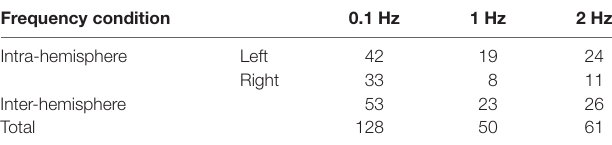
TABLE 1 | The number of significant functional connectivity (FC N